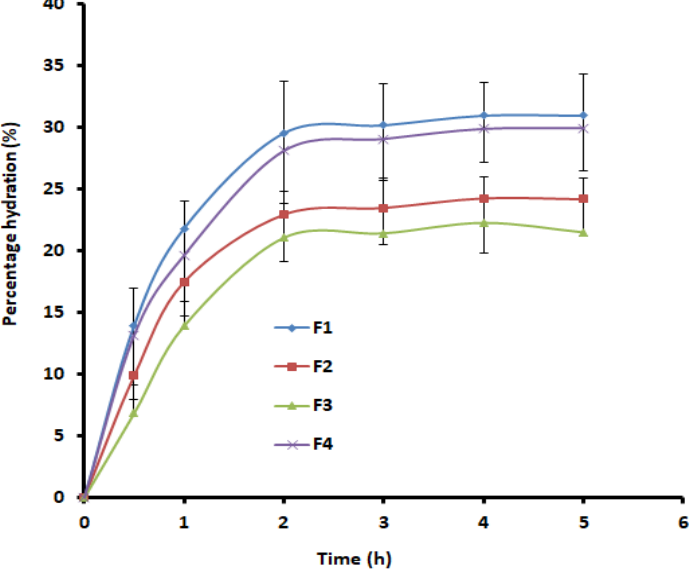
Figure 1. Comparison of percentage hydration of buccal films (F1–F4). Data represented are mean ± SD ( n = 6).